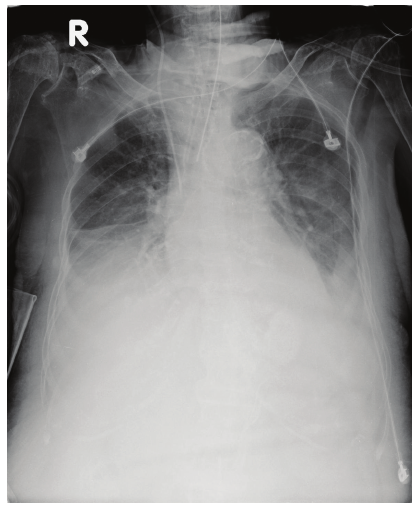
Figure 2: Day 1 on steroid therapy.